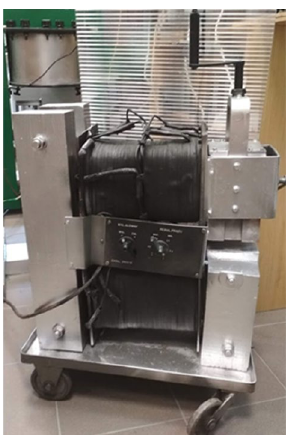
Figure 2. Electromagnet. Photo by Agata Dziwulska-Hunek.